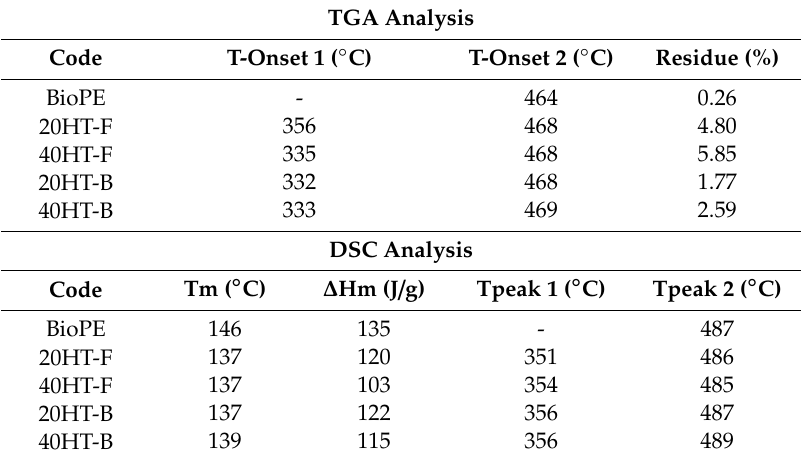
Table 3. Thermo-gravimetric analysis (TGA) and di ff erential scanning calorimetry (DSC)